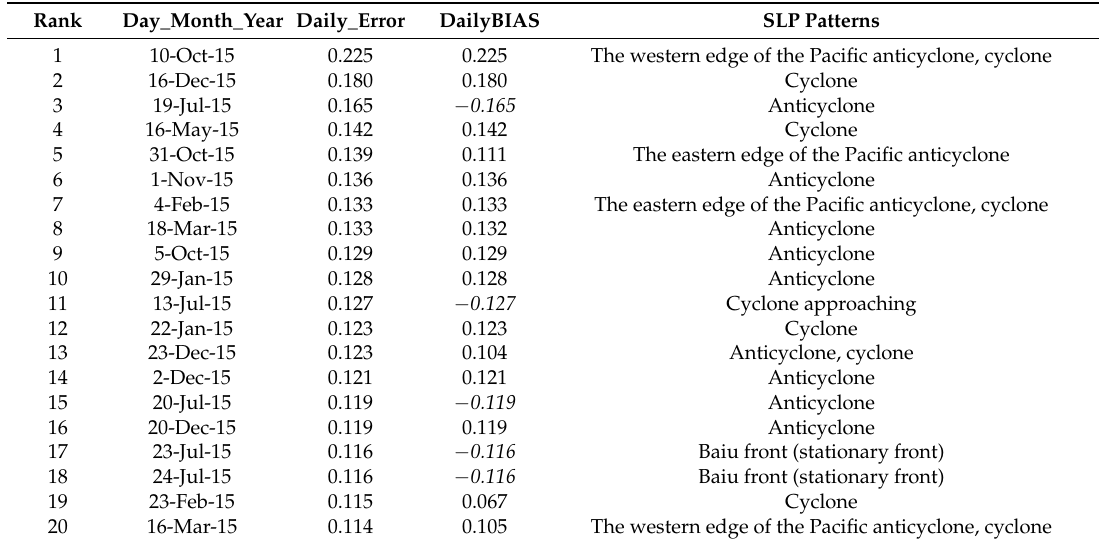
Table 3. Same as Table 2, but for 2015.